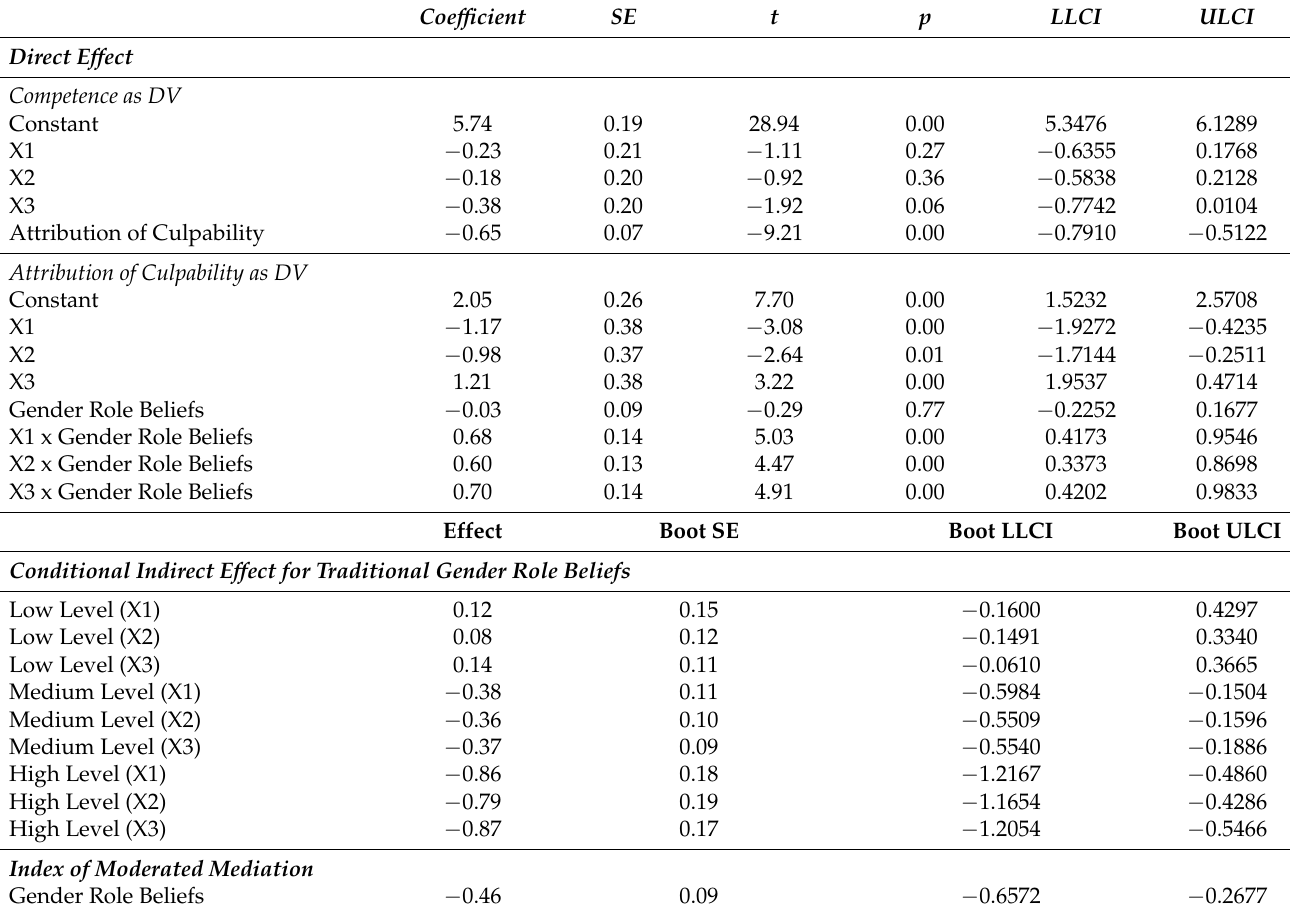
Table 2. Moderated-Mediation